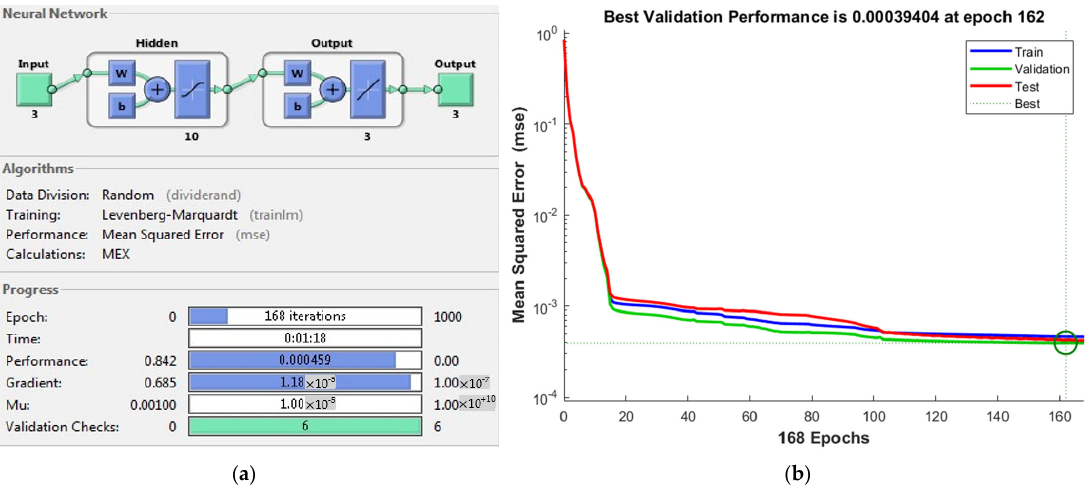
Figure 11. ANN architecture of the flux controller and its evolution into training ( a ). Performance of the mean quadratic error (training, testing, validation) ( b ).